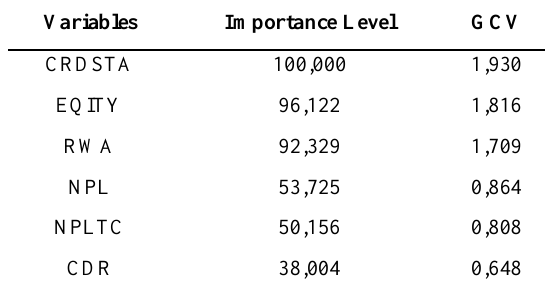
Table 5: Importance Level of Independent Variables